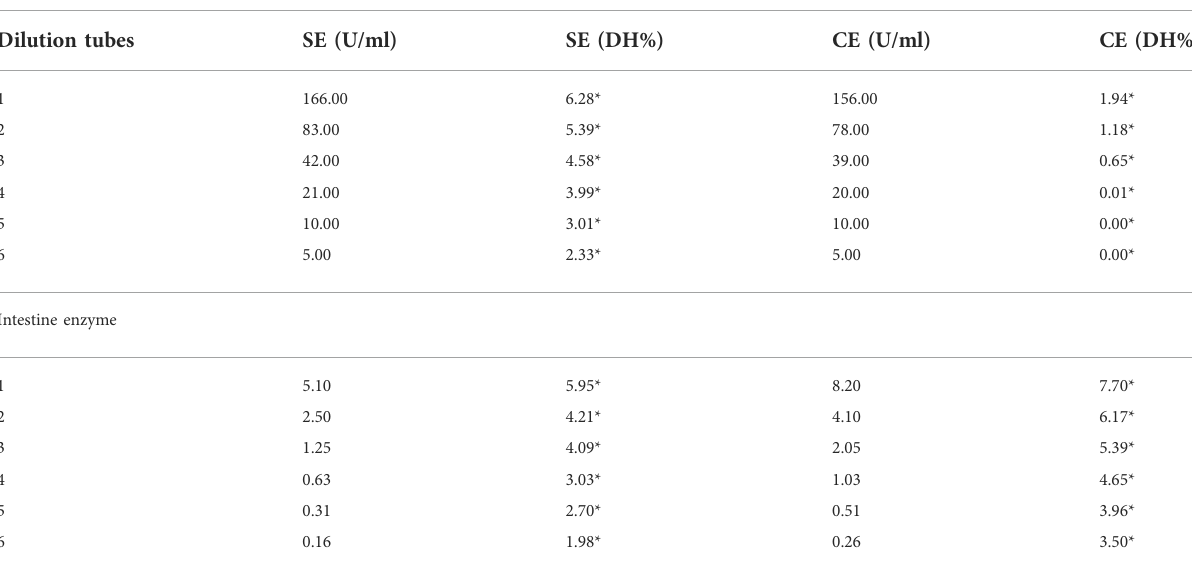
TABLE 3 The enzyme activity, and protein hydrolytic performance (DH%) of salmon enzyme and commercial enzyme on the standard substrate, hemoglobin, and casein. Stomach enzyme Dilution